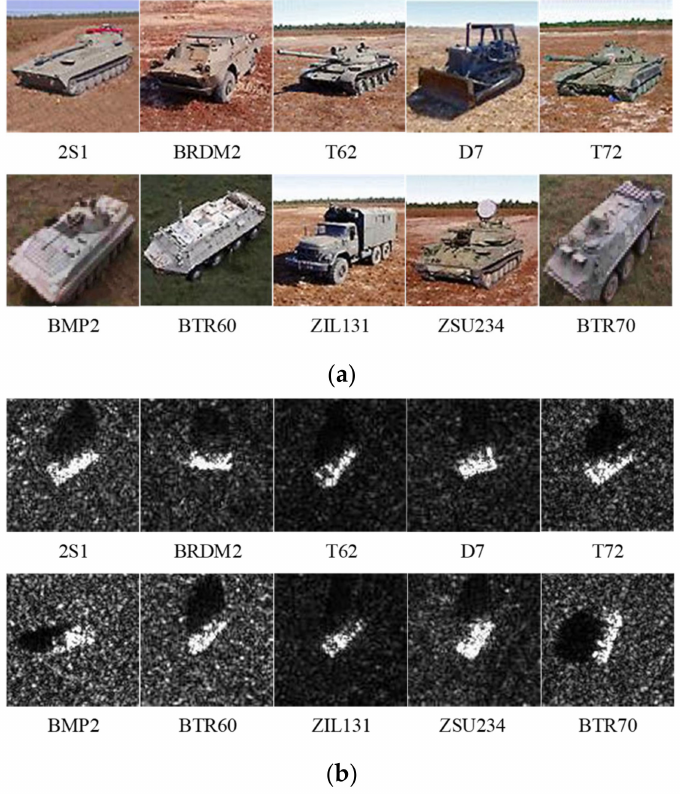
Figure 4. Images of each category in the MSTAR dataset. ( a ) Optical images. ( b ) SAR